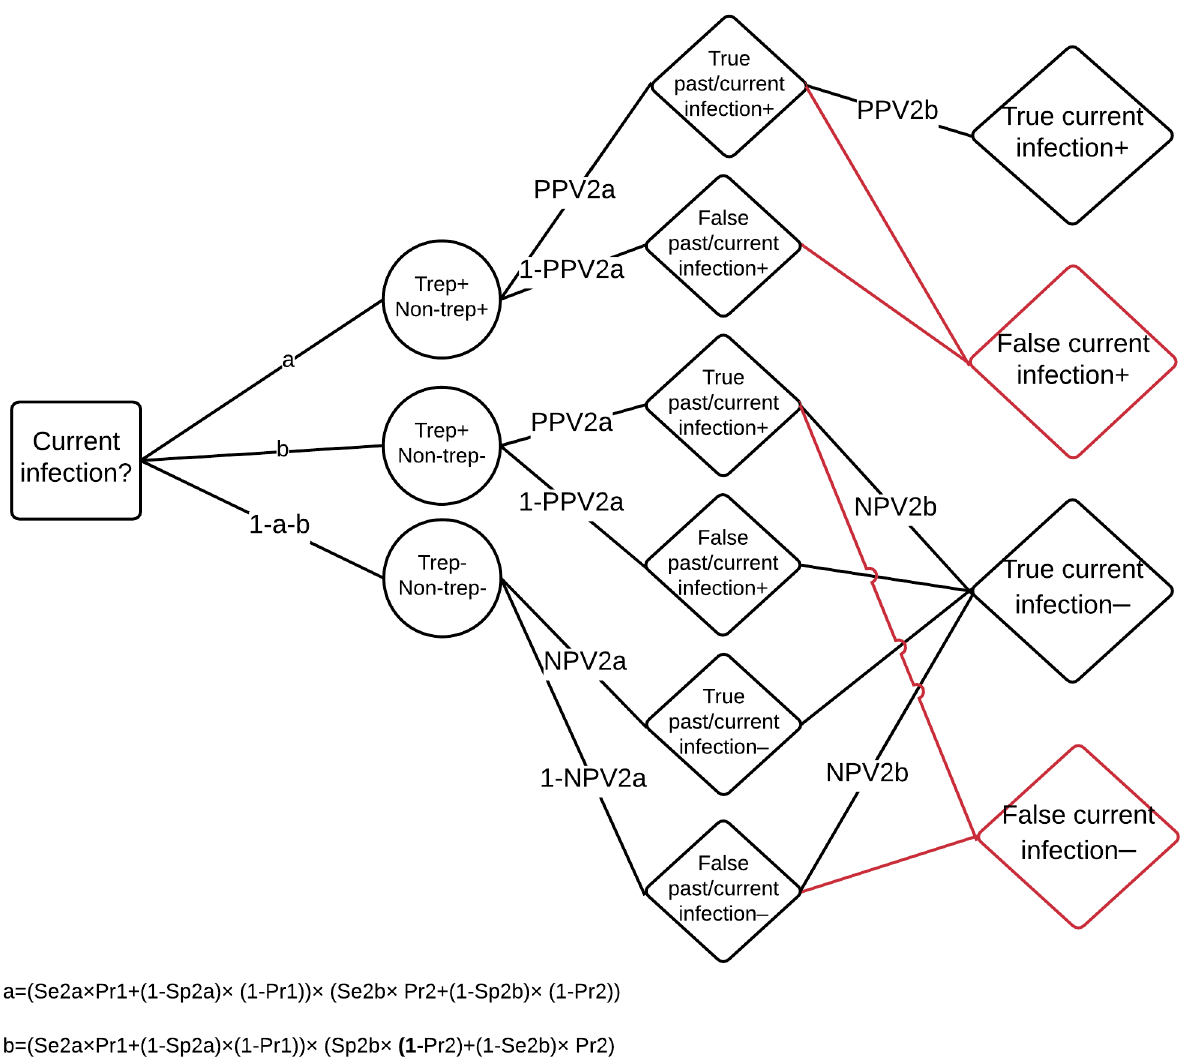
Fig 2. Decision model of diagnosis of current infection under the combined testing strategy. The decisionto be made is whether an individualhas current infectionor not (box); the individual’scombinedtest result (circles) can be either: dually positive (suggesting current infection), treponemalpositive only (past infection),or duallynegative (never any infection);this dependson the Sensitivity (Se) and Specificity (Sp) of the treponemal line (Se2a and Sp2a, respectively)and of the non-treponemal line (Se2b and Sp2b), as well as on the prevalence of past/current infectionin the total population(Pr1) and the prevalence of current infectionin the populationof past/current infections(Pr2); the treponemalline provideseither a true or false diagnosis of past/current infection; this depends on Positive Predictive Value (PPV) and Negative Predictive Value (NPV) of the treponemal line (PPV2a and NPV2a, respectively); PPV is calculatedas (Se × Pr1) (cid:4) (Se × Pr1+(1–Sp) × (1–Pr1)); NPV is calculatedas Sp × (1–Pr1) (cid:4) ((1-Se) × Pr1+Sp × (1–Pr1)); the non-treponemal line provides either a true of false diagnosisof current infection; this dependson PPV and NPV of the non-treponemal line (PPV2b and NPV2b), using the prevalence of current infectionin the populationof past/current infections(Pr2); red lines indicatepathways to false diagnoses of current infection; note, the treponemalline can give a false positive diagnosis of past/current infectionand yet the non-treponemal line can still give a correct overall diagnosis of no current infection.